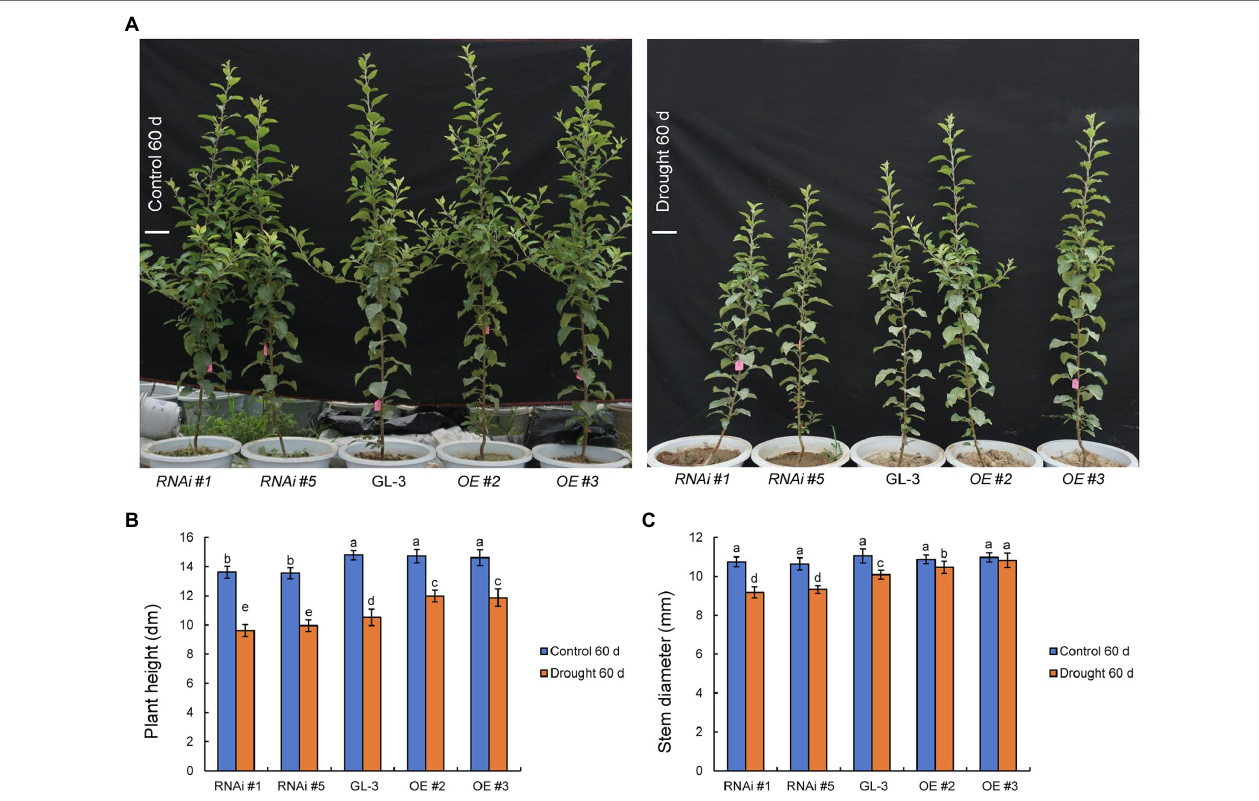
FIGURE 1 | Comparison of the growth status of GL-3 and transgenic apple plants under long-term moderate soil water deficit. (A) Phenotypic comparison of GL-3 and MdHB-7 transgenic apple plants grown in well-watered and moderate soil water deficit conditions for 60 days. RNAi and OE represent the MdHB-7 -RNAi and MdHB-7 - overexpressing apple plants, respectively. Scale bars, 10 cm. (B) Plant height. (C) Stem diameter. Data are means ± SD ( n = 18 for B , C ; 18 plants from each line). Different letters indicate significant differences between GL-3 and transgenic apple plants based on one-way ANOVA and Tukey’s multiple range test ( p <